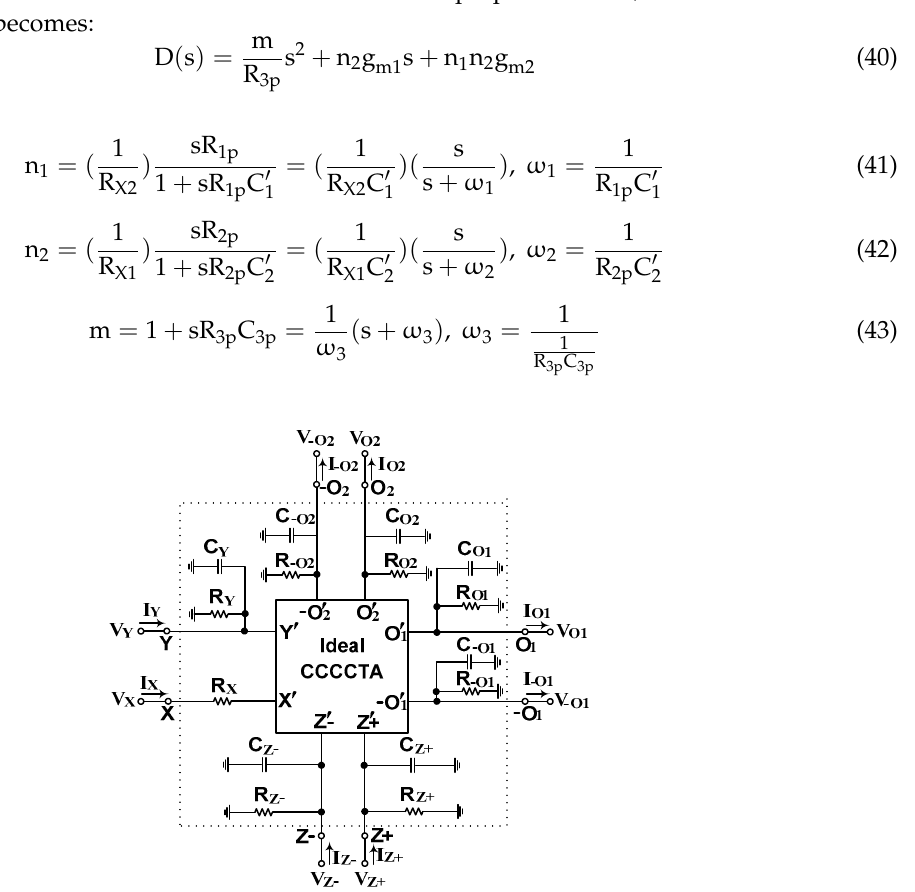
Figure 3. Non-ideal equivalent circuit model of the CCCCTA.